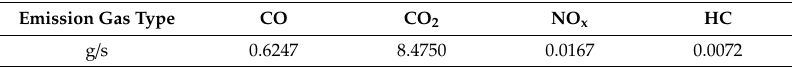
Table 4. Related specific power exhaust